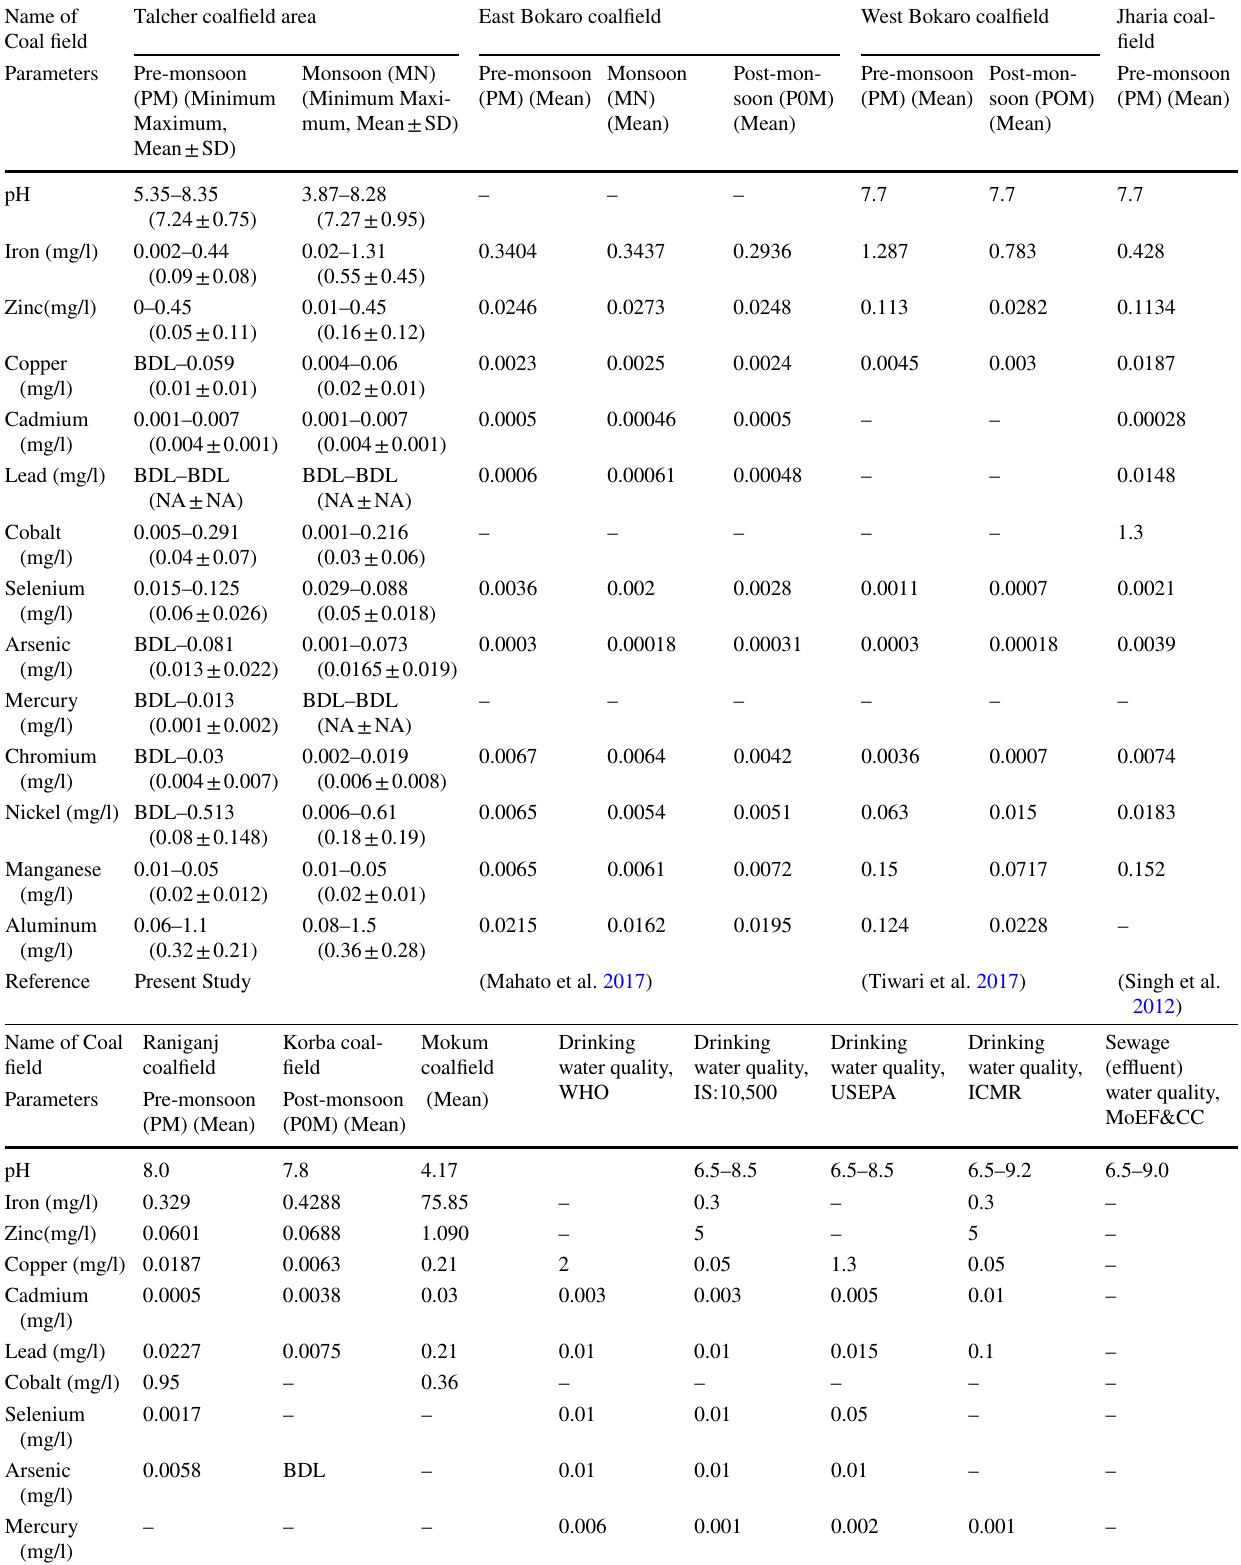
Table 2 Seasonal variation in metal concentrations in the surface water of Talcher coalfield and comparison with other studies and various